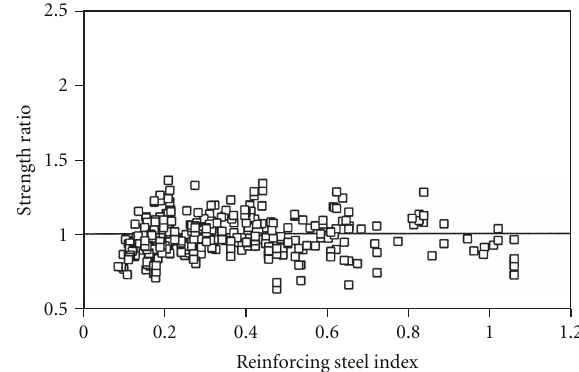
Figure 7: E ff ect of slenderness ratio (cid:2)/h on FEM strength ratios for reinforced concrete columns ( n = 354).